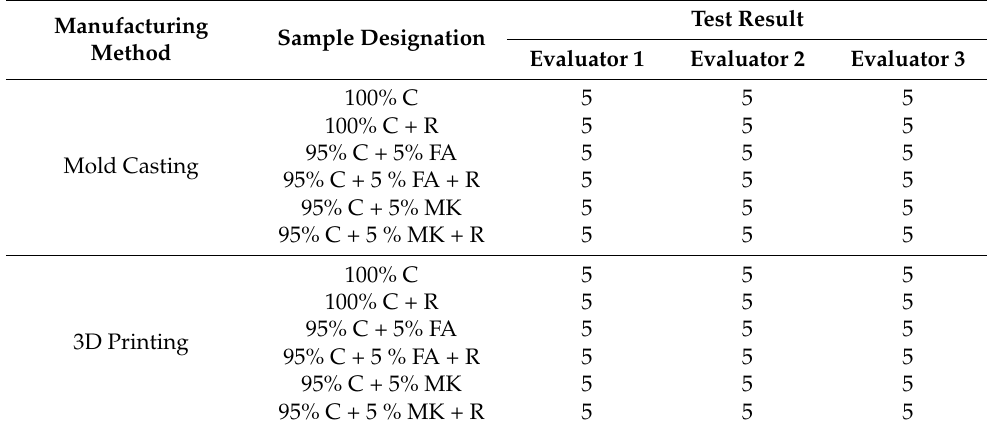
Table 3. Results of the evaluation of the color change in a grayscale of concrete and concrete– geopolymer hybrid